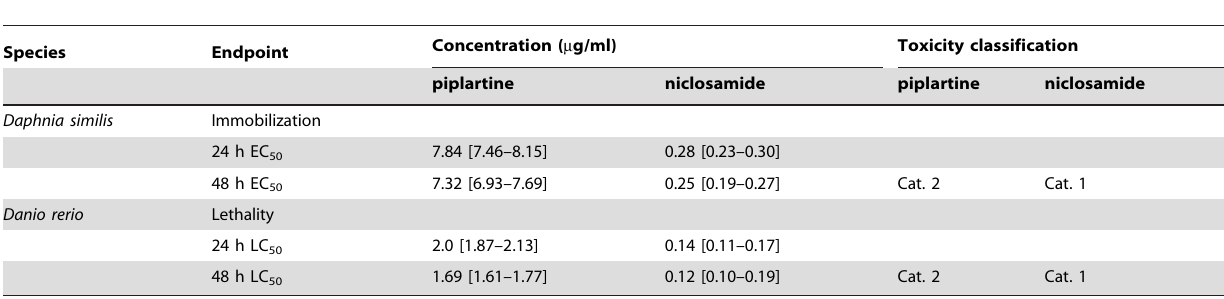
Data are presented as EC 50 or LC 50 ( m g/ml) with the respective 95% confidence limits in brackets. Toxicity classification: Cat. 1 - acute toxicity # 1.00 m g/ml; Cat. 2 - acute toxicity . 1.00 but # 10.0 m g/ml; Cat. 3 - acute toxicity . 10.0 but , 100 m g/ml